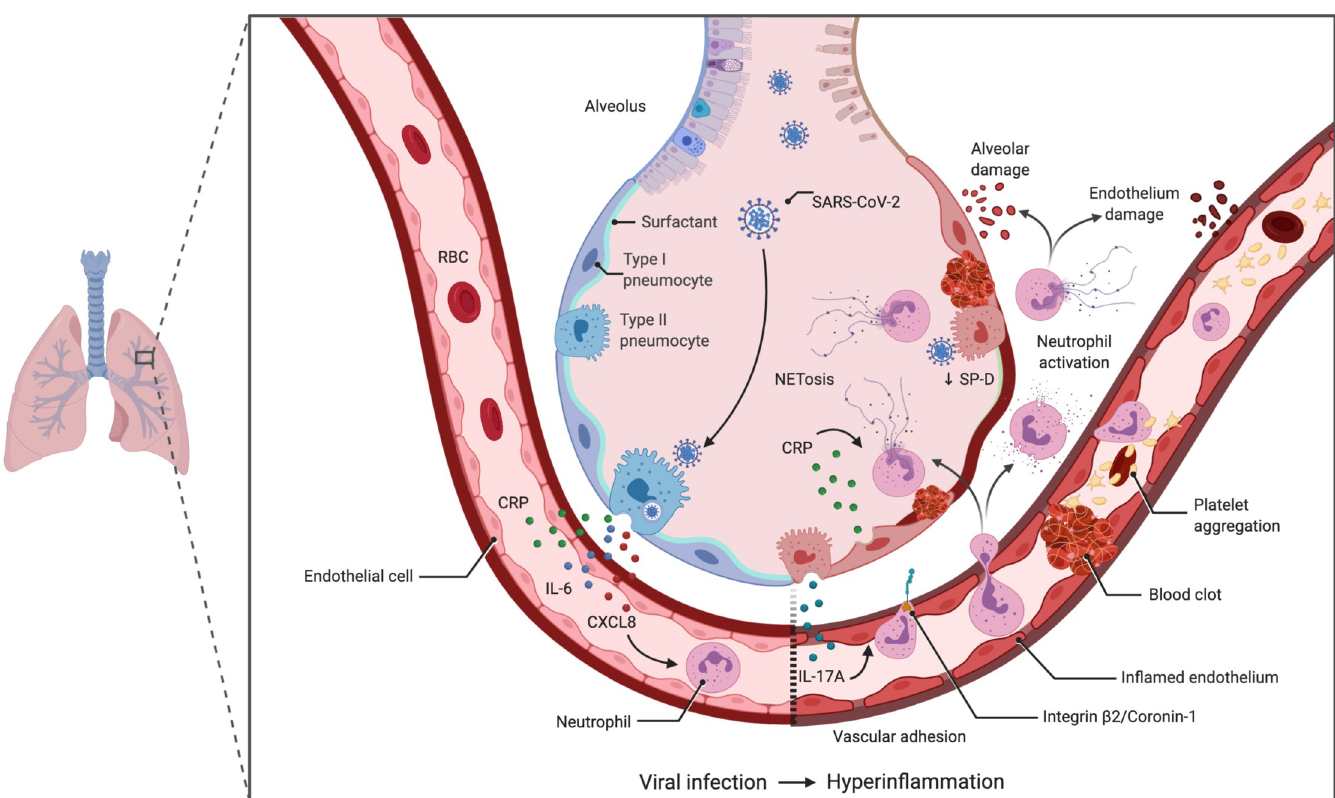
Fig 5. Model of NET-mediated endothelial damage contributing to pulmonary vascular thrombosis in severe COVID-19. Infection by SARS-CoV-2 in vulnerable population will lead to hyperinflammation either from underlying genetic mutations, specific epigenetic landscapes or external factors, that will result in the increase circulation of acute phase reactants such as CRP and pro-inflammatory cytokines associated with neutrophilia like IL-6, IL-17A/F and CXCL8 (IL-8). IL-17A activates the endothelium to induce neutrophil adhesion [105], where the increase in CRP can trigger the release of NETs, resulting in damage to the endothelium as well as aggregation and activation of platelets. Additionally, the presence of SARS-CoV-2 E protein in type II pneumocytes could disturb the surfactant cargo via its interaction with AP3B1, leading to impaired secretion of SP-D and greater NET formation by septal and intra-alveolar neutrophils increasing the risk of thrombosis in the pulmonary microvasculature. In some predisposed patients the combinations of these mechanisms will lead to severe COVID-19 complications. The identification of mediators of this pro-coagulation cascade is essential in achieving the two-fold task of identifying vulnerable populations and developing a personalized medicine